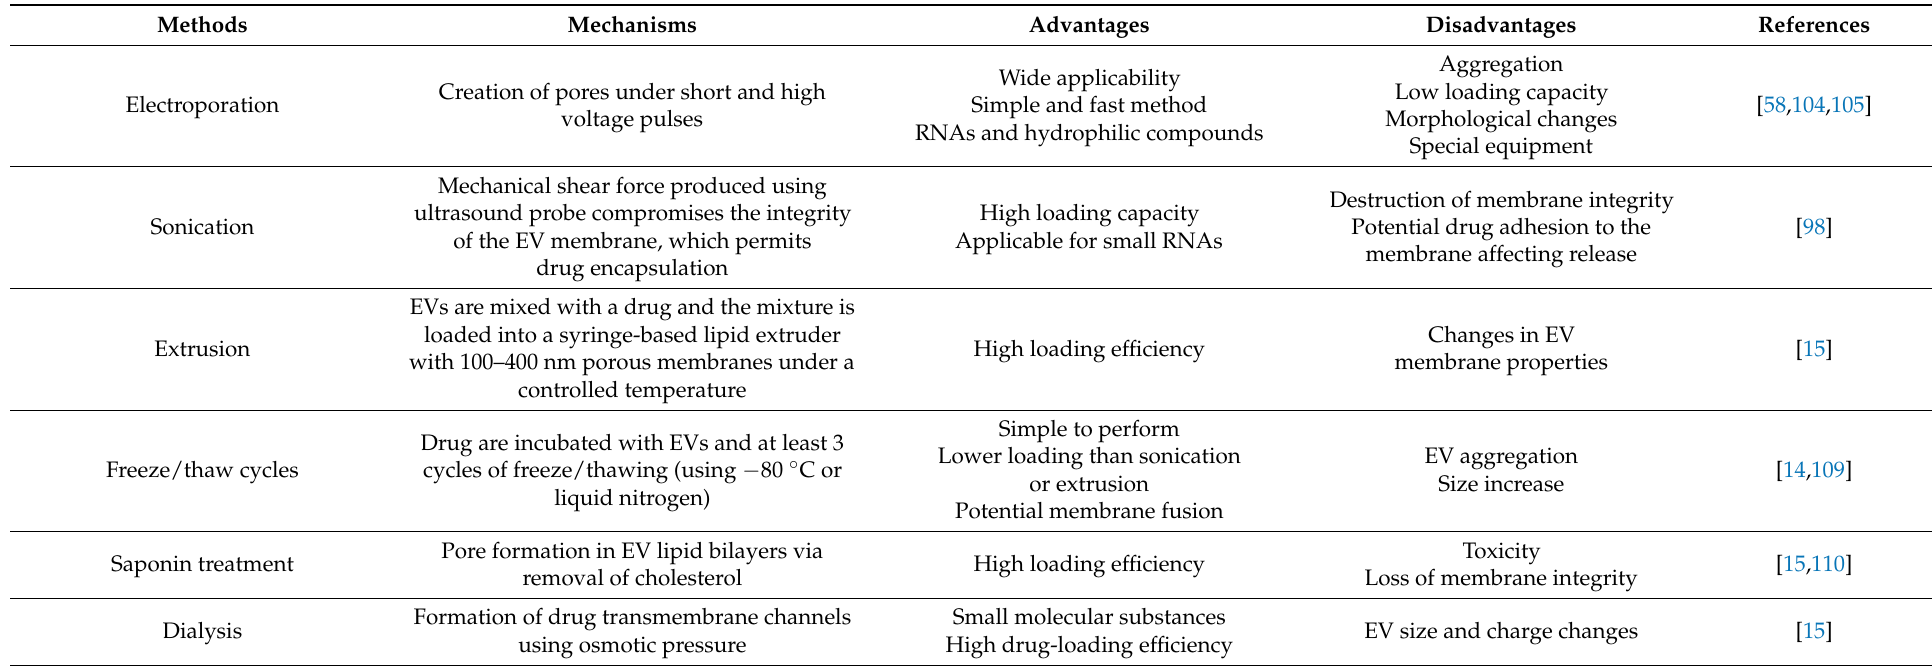
Table 2. Principal methods for loading cargo in EVs after their isolation: advantages and